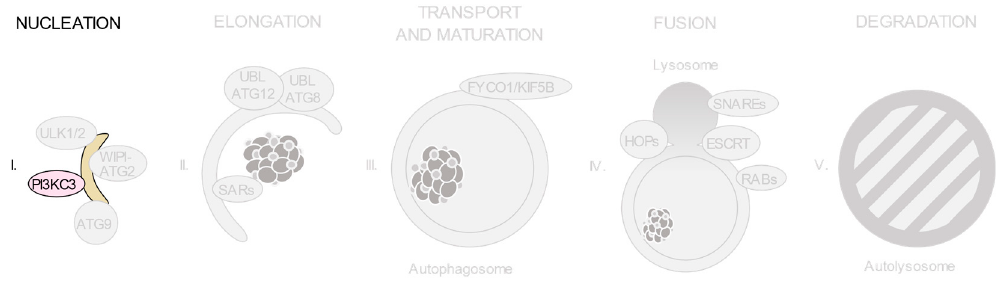
Figure 4. The phosphatidylinositol 3-kinase (PI3KC3) complexes participate in the nucleation of the pre-autophagosomal membrane.